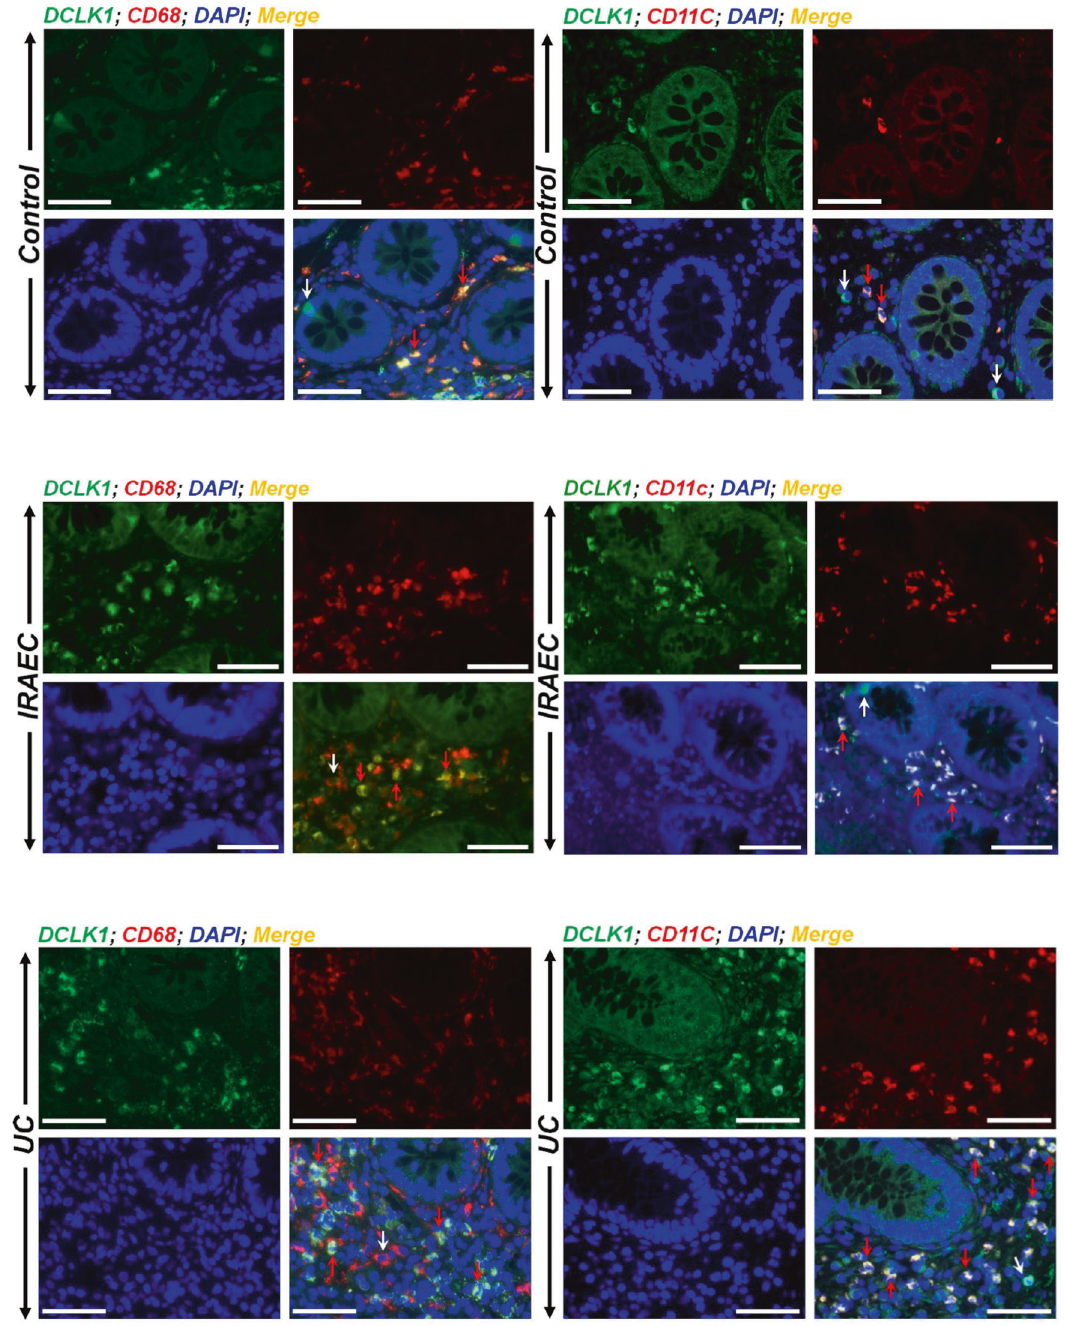
Fig. 2 Immune cells associate with DCLK1 in the colons of UC and IRAEC patients. Paraf fi n-embedded sections from control or immune- mediated colitis (IRAEC) and ulcerative colitis (UC) patients were co-stained with antibodies for DCLK1/CD68 and DCLK1/CD11c, respectively. Nuclei were stained with DAPI (blue). Signi fi cant co-localization of DCLK1 with both CD68 and CD11c representing macrophages and dendritic cells, respectively, was recorded in the sub-mucosal (stromal) regions in the colons of IRAEC or UC patients compared to control (red arrows) while a subset of DCLK1 + cells did not co-localize with either cell type (white arrows). Scale bar = 100 μ m; n = 2 independent